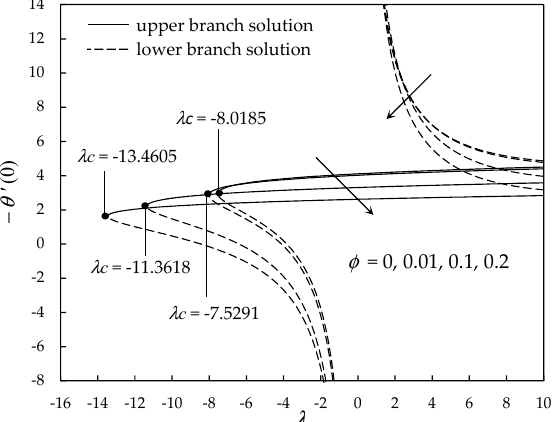
Figure 3. Variation of the reduced local Nusselt number − θ (cid:48) ( 0 ) with the mixed convection parameter λ for several values of the volume fraction of nanoparticles φ when Nr = 0.1, K = − 0.1, c = − 1 and s = 1 for Cu-water nanofluid.